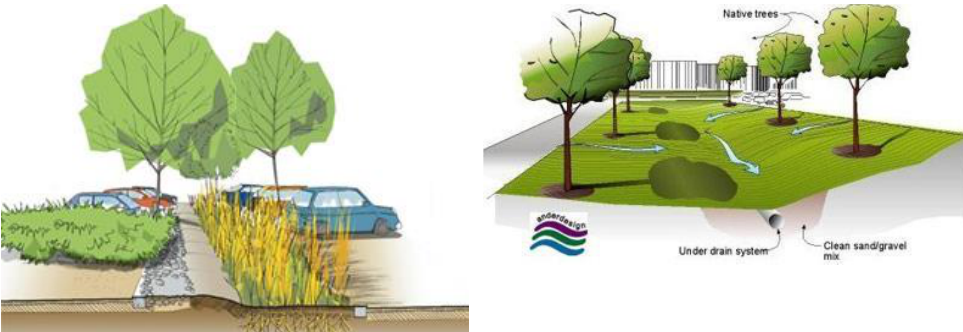
Figure 10. Plan for the sustainable drainage system in Belgrade (https://www.sllistbeo- grad.rs/pdf/2019/110-2019.pdf, accessed on 28 August 2022). 2019/110-2019.pdf, accessed on 28 August